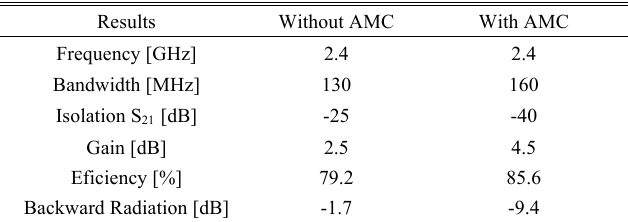
TABLE II. CP-MIMO antenna with and without